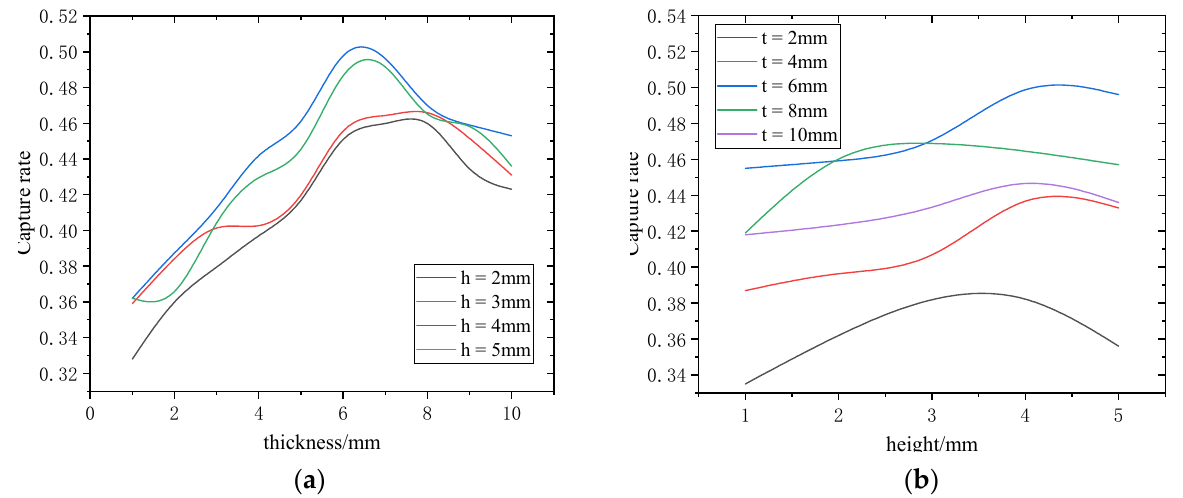
Figure 12. Influence of trap parameters on capture rate: ( a ) effect of thickness and ( b ) effect of height.